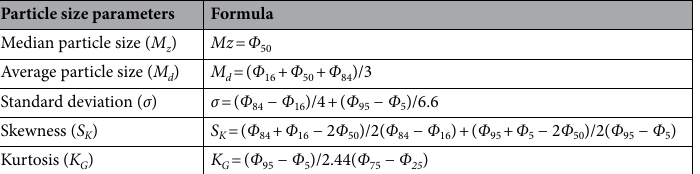
Particle size parameters Formula Median particle size ( M z ) Mz = Ф